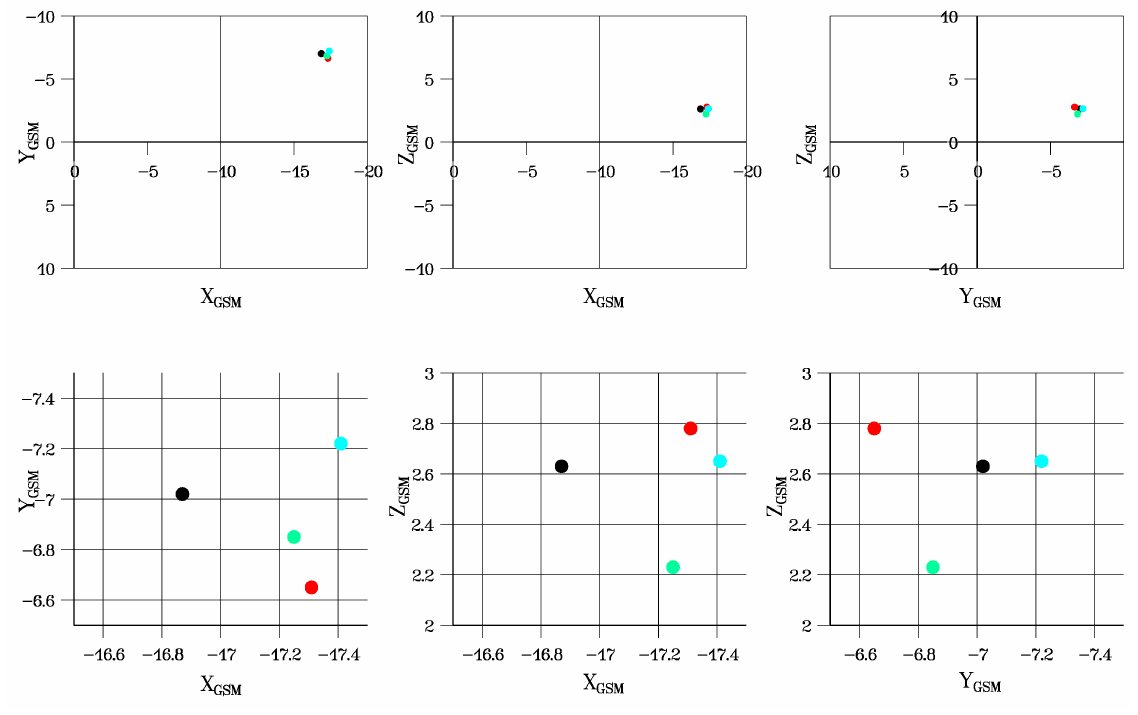
Fig. 1. Cluster spacecraft positions. Upper row: Large-scale view; lower row: Inter-spacecraft separations view. Black: Cluster 1; red: Cluster 2; green: Cluster 3; blue: Cluster